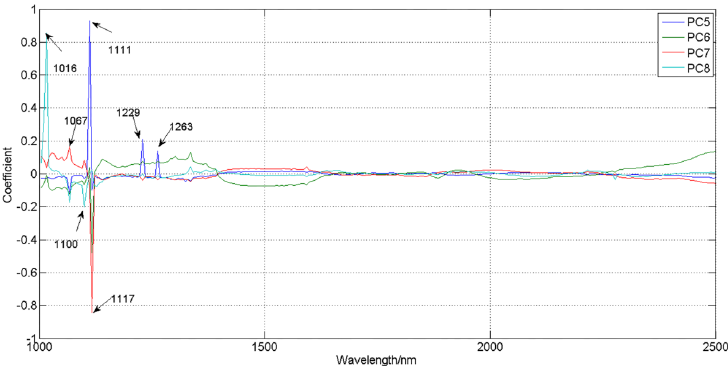
Figure 3. Loading line plot of PC 5 –PC 8 of the mosaic image.